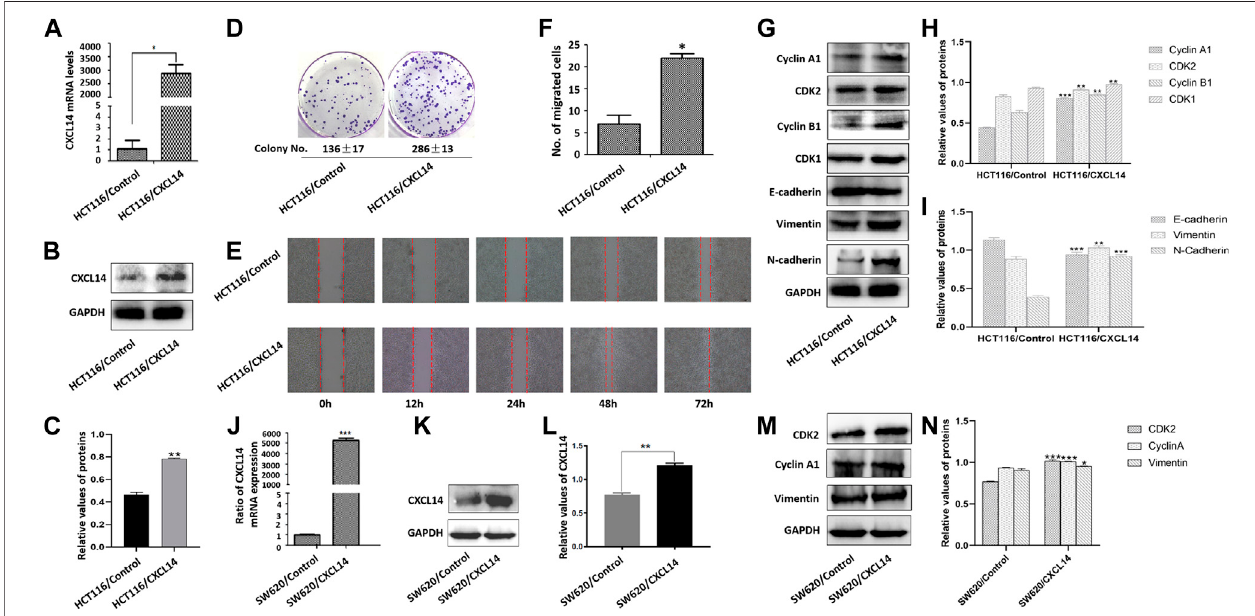
FIGURE 5 | Effects of CXCL14 on cell proliferation and migration of human colorectal cancer cells. CXCL14 was stably over-expressed in the HCT116 cells, as determined by RT-PCR assay (A) and western blot assay (B) . (C) Quantitative results of CXCL14 expression levels. (D) The proliferative capacity of HCT116 cells stably expressingCXCL14(HCT116/CXCL14)wasstrongerthanthatofHCT116/Controlonlytransfectedwithemptyvectors,asmeasuredbycolonyformationassay. (E) The migratory capacity of HCT116/CXCL14 was stronger than that of HCT116/control cells, as measured by wound healing assay. (F) Quantitative results of cell migration numbers in modi fi ed Boyden chamber assays in HCT116/Control cells and HCT116/CXCL14 cells. (G) The expression levels of cell cycle-related and EMT- related proteins in HCT116/CXCL14 cells and HCT/Control cells were measured by western blot. (H) Quantitative results of cell cycle-related protein expression. (I) Quantitative results of EMT-related protein expression. CXCL14 was stably over-expressed in the SW620 cells, as determined by RT-PCR assay (J) and western blot assay (K) . (L) Quantitative results of CXCL14 expression levels. M. The expression levels of CDK2, Cyclin A1, vimentin in HSW620/CXCL14 cells, and SW620/Control cells were measured by western blot. (H) Quantitative results of protein expression. The experiments were performed in triplicate ( n (cid:1) 3). Error bars represent mean ± S.D. p < 0.05 was considered to be statistically signi fi cant. * p < 0.05; ** p < 0.01, *** p < 0.001.